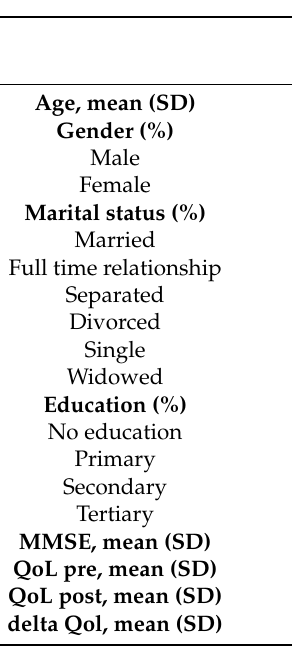
Table 1. Socio-demographic data of